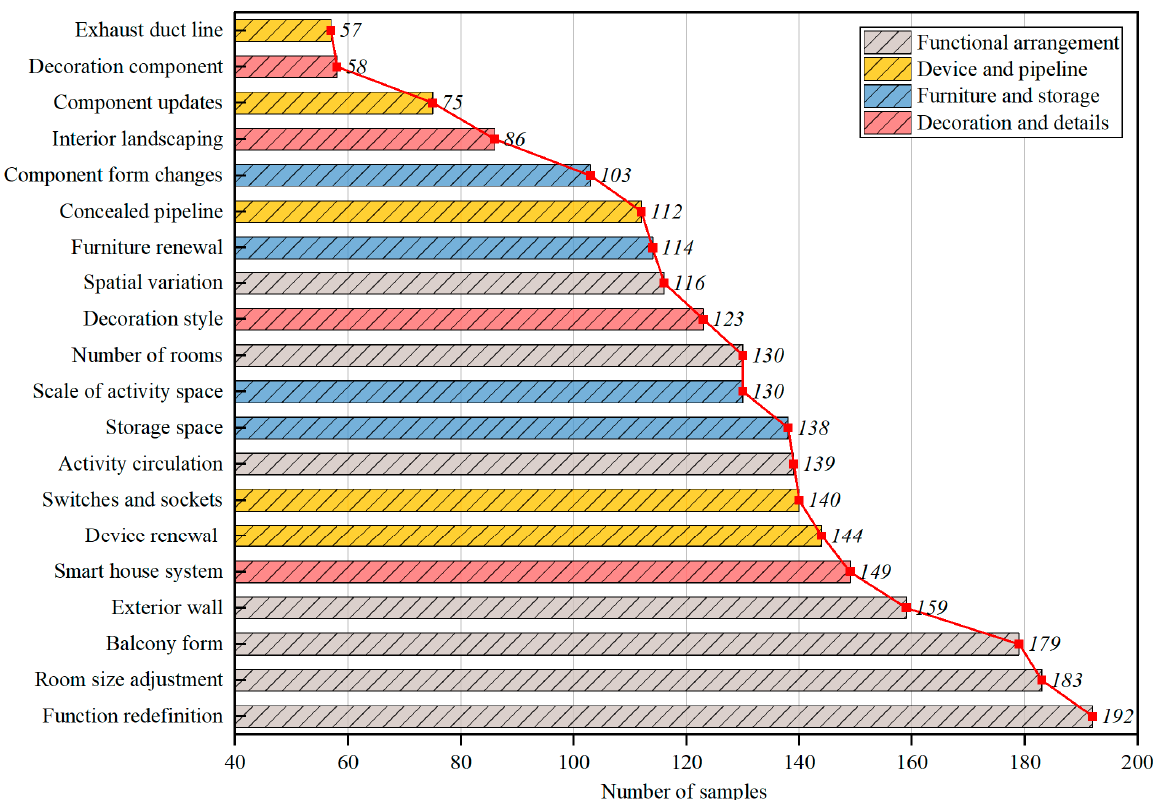
Figure 4. Expectations of the flexibility of specific components.